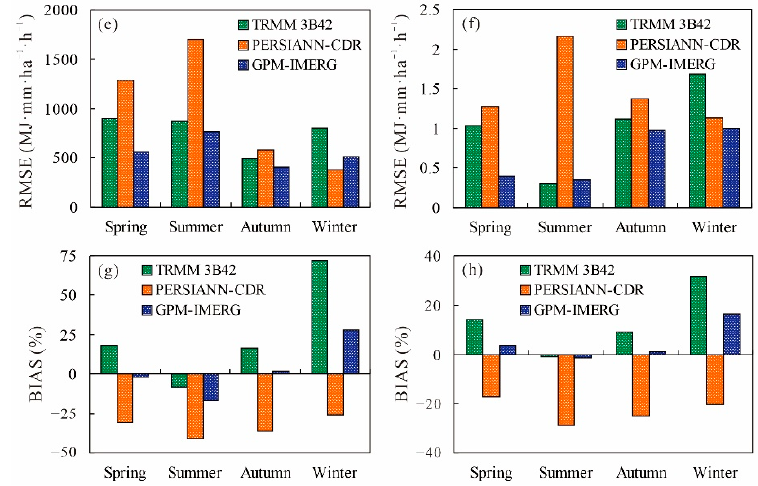
Figure 3. Seasonal variation of R, ME, RMSE, and BIAS (( a , c , e , g ) for rainfall erosivity; ( b , d , f , h ) for erosivity density).